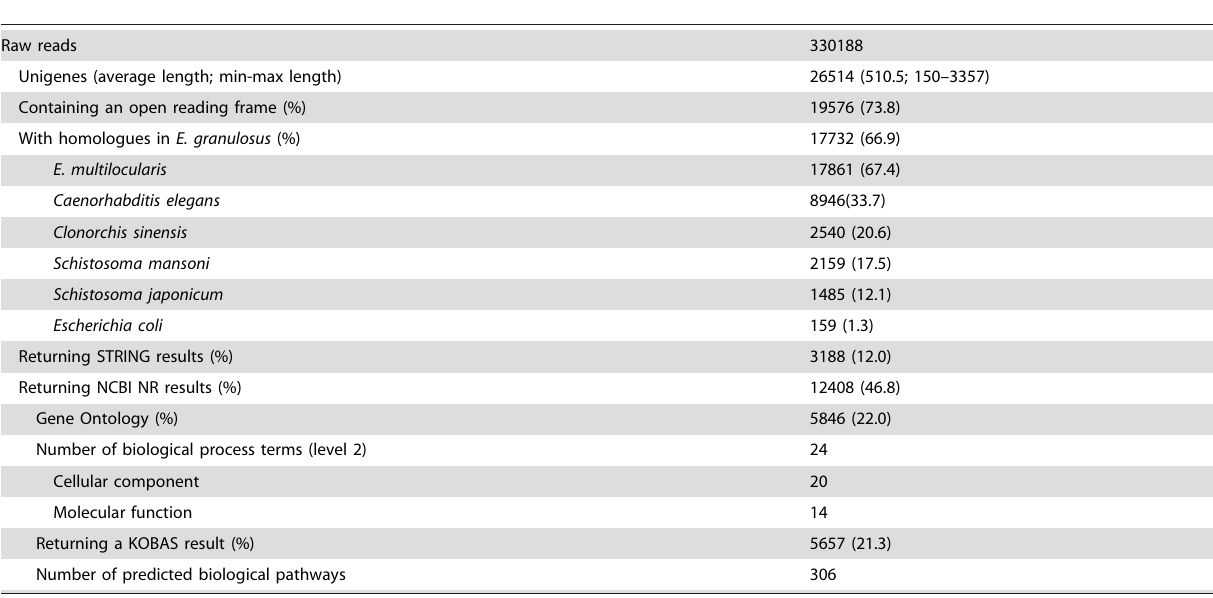
Table 1. Summary of the nucleotide sequence data for EgPSCs prior to and following assembly, with detailed bioinformatic annotation and